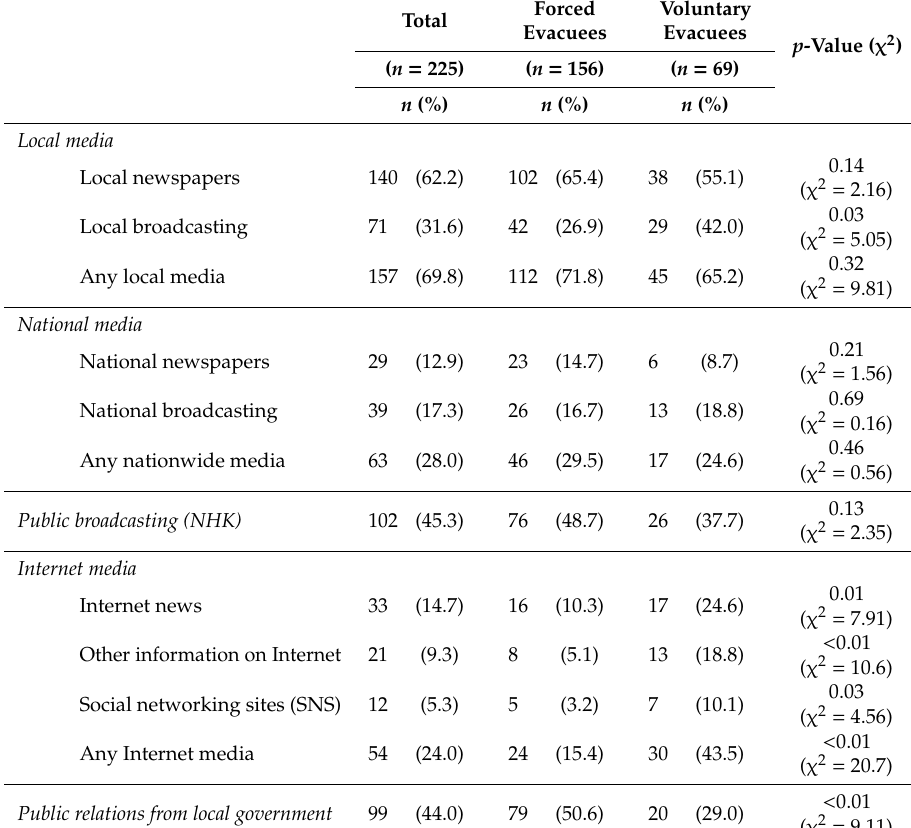
Table 2. Utilization of media relating to nuclear exposure among evacuees (forced / voluntary).